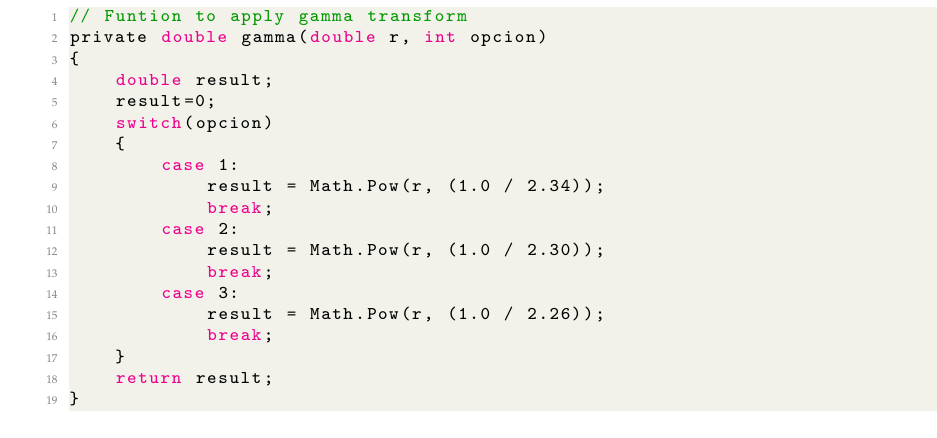
Algorithm 1: Algorithm transformation from XYZ values to RGB Algorithm 1: Gamma function Algorithm 2: Gamma function example. Algorithm 1: Gamma function example